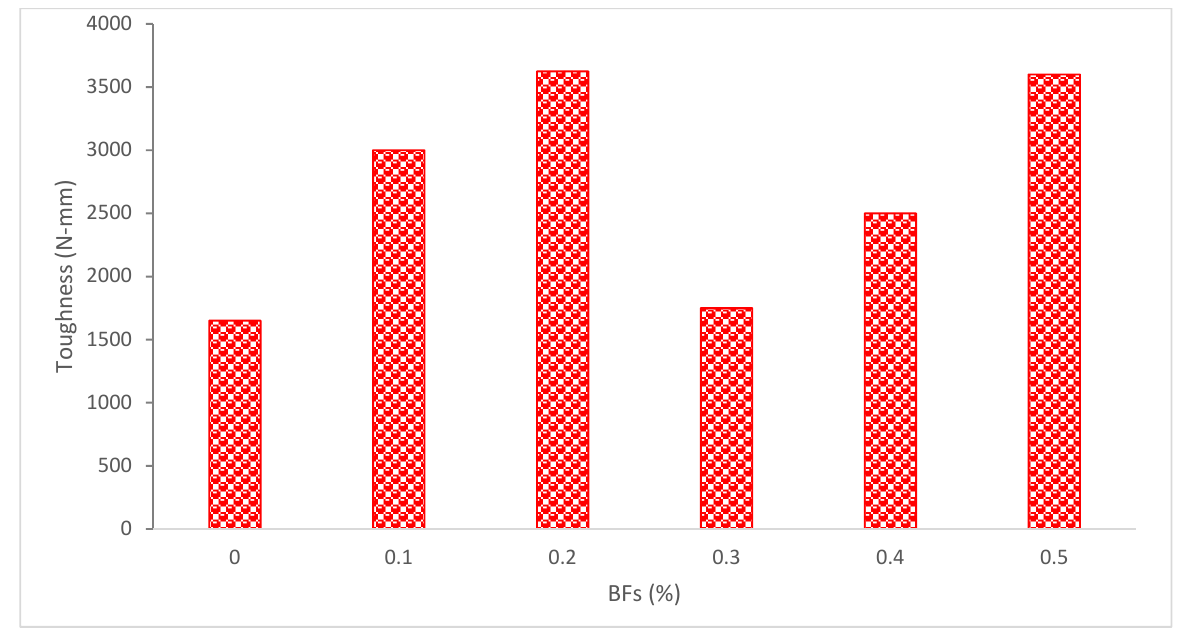
Figure 18. Toughness of Basalt Fibers Reinforced Concrete: Data Source [61].